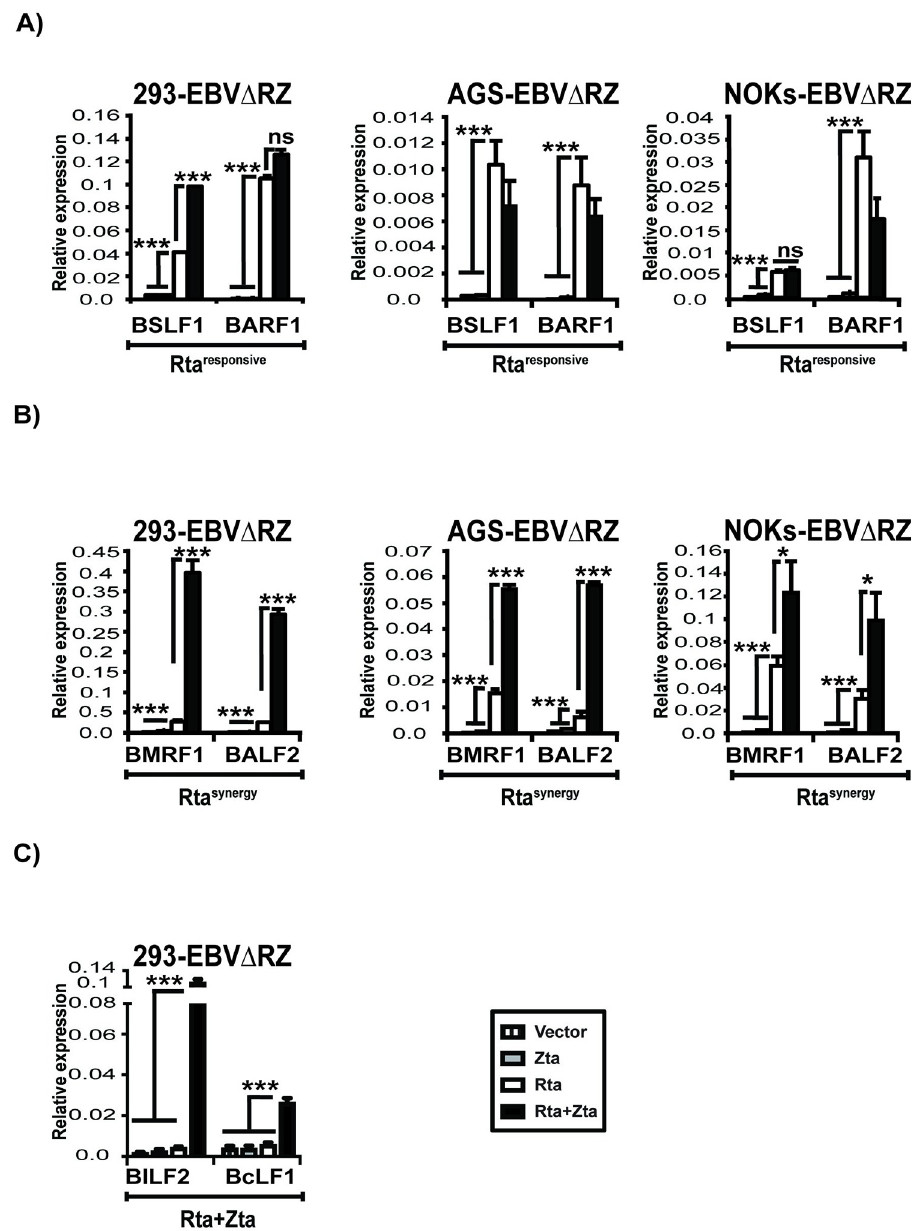
Fig 4. Classification of EBV lytic genes based on their Rta and Zta dependencies. Real time-qPCR data displaying the relative expression of various EBV lytic transcripts in 293-EBV Δ RZ, AGS-EBV Δ RZ and NOKs-EBV Δ RZ. (A) Rta responsive transcripts (BSLF1 and BARF1) depend only on Rta for expression. (B) Rta synergy transcripts (BMRF1 and BALF2) are activated by Rta, but expressed at higher levels with Zta co-expression. (C) Rta+Zta transcripts (BcLF1 and BILF2) require both Rta and Zta transfection to be expressed. Results are expressed as mean values ± the standard error of the mean across two (AGS-EBV Δ RZ, NOKs-EBV Δ RZ) or one (293-EBV Δ RZ) biological replicate. Data shown are representative of two independent experiments. Significant differences are indicated as follows: P � 0.05 ( � ), P � 0.01 ( �� ), P � 0.001 ( ��� ), P > 0.05 (ns).